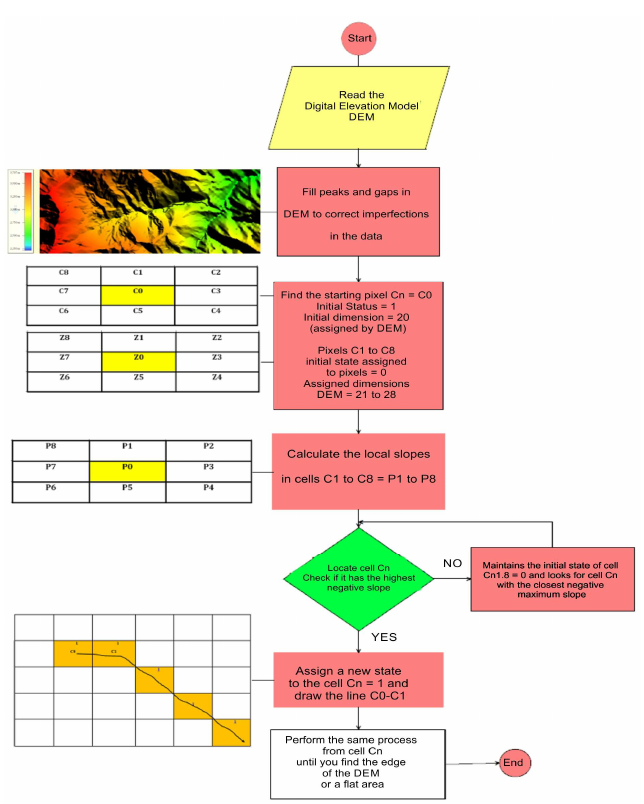
Figure 2. Process followed for the extraction of surface runoff flows from precipitation water in the D8 hydrological model.